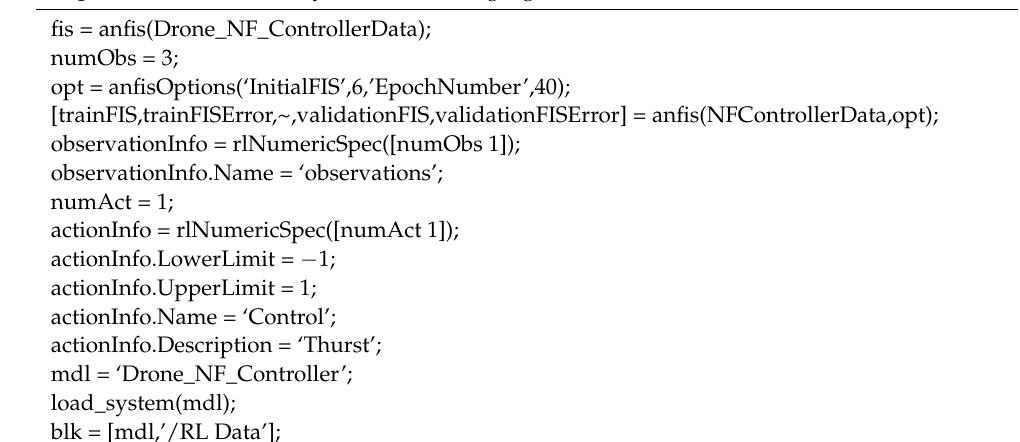
Algorithm 2. is algorithm for ANFIS controller using Matlab/Simulink. Algorithm 2: Neural-Fuzzy controller setting algorithm